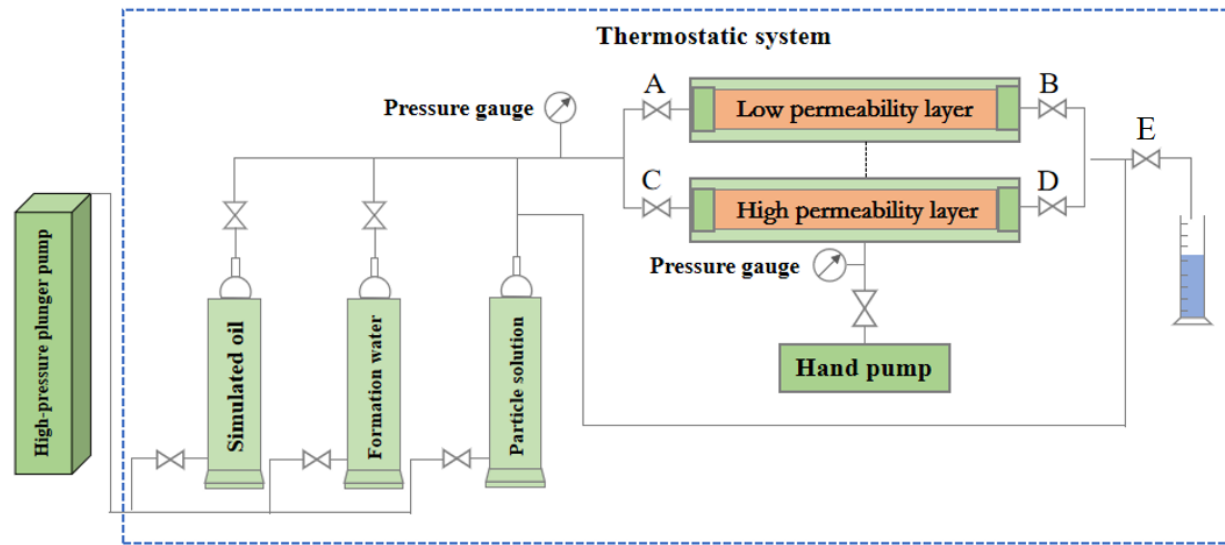
Figure 1. Experimental setup for core flow.